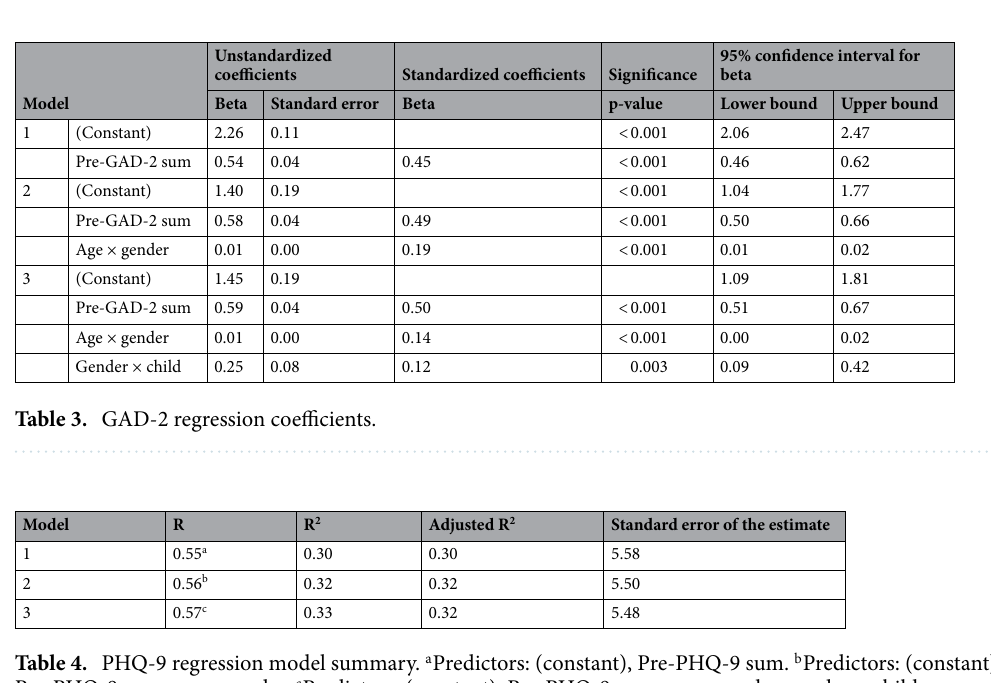
associated with increased levels of post-pandemic PHQ-9 scores.